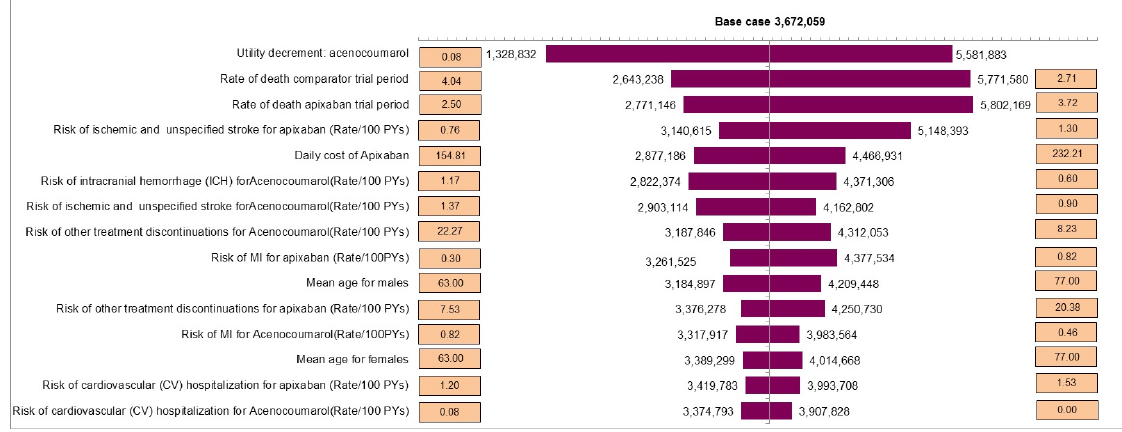
*Top 15 parameters that the ICERs are most sensitive to